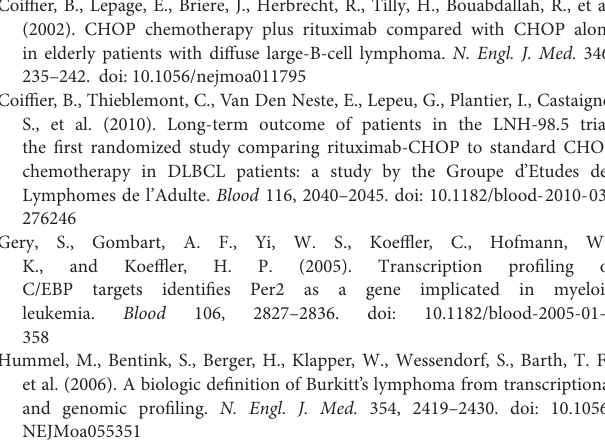
Supplementary Figure 1 | The principal component analysis (PCA) of the discretized expression profiles of the three cohorts used for model training. Supplementary Figure 2 | The association of risk scores derived from the three previous gene signature sets with IPI scoring system and tumor stage. Supplementary Table 1 | Clinical difference between the three cohorts used for model